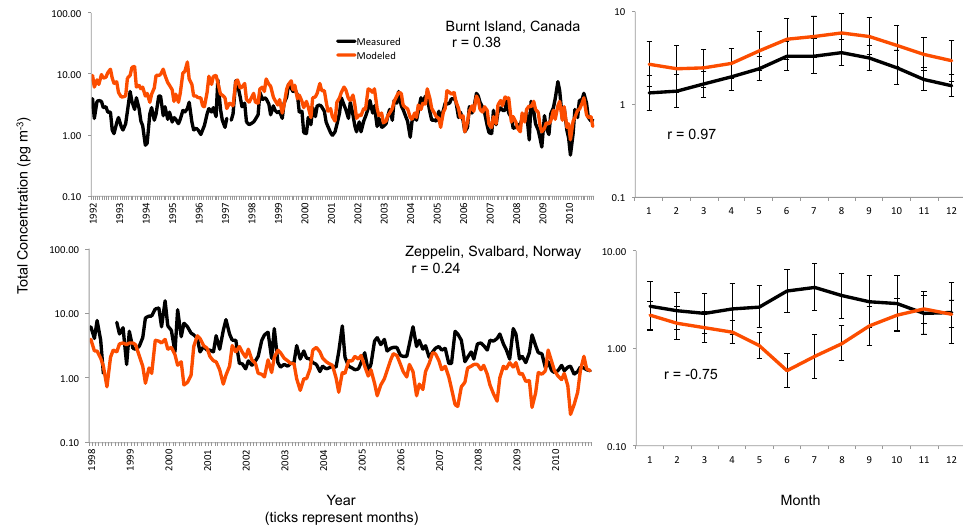
Figure 3. Total measured and simulated monthly mean concentrations of CB 28 at Burnt Island, Canada (top row), and Zeppelin, Norway (bottom row). The left-hand column is the full time series, while the right-hand column is an average of the data on the left over all years.